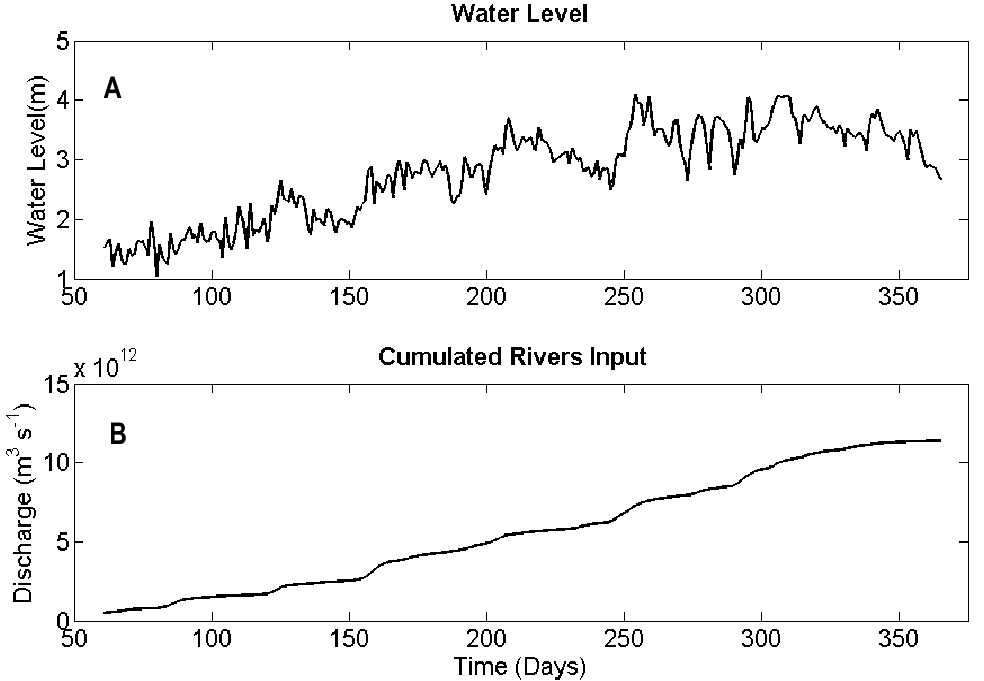
Figure 5. ( A ) Calculated water level in the Mirim lagoon at station P1 and ( B ) cumulated rivers input in the lagoon (Jaguarão, Cebollati, and Taquari rivers) for 2002.